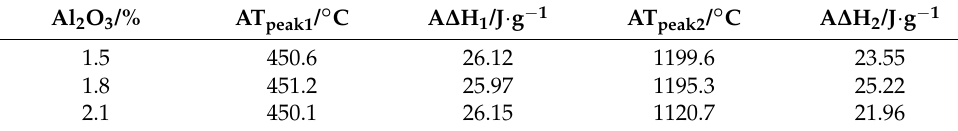
Figure 11. DSC curves of the raw material with different Al 2 O 3 contents. Table 4. Peak temperature and heat of materials with different Al 2 O 3 contents.